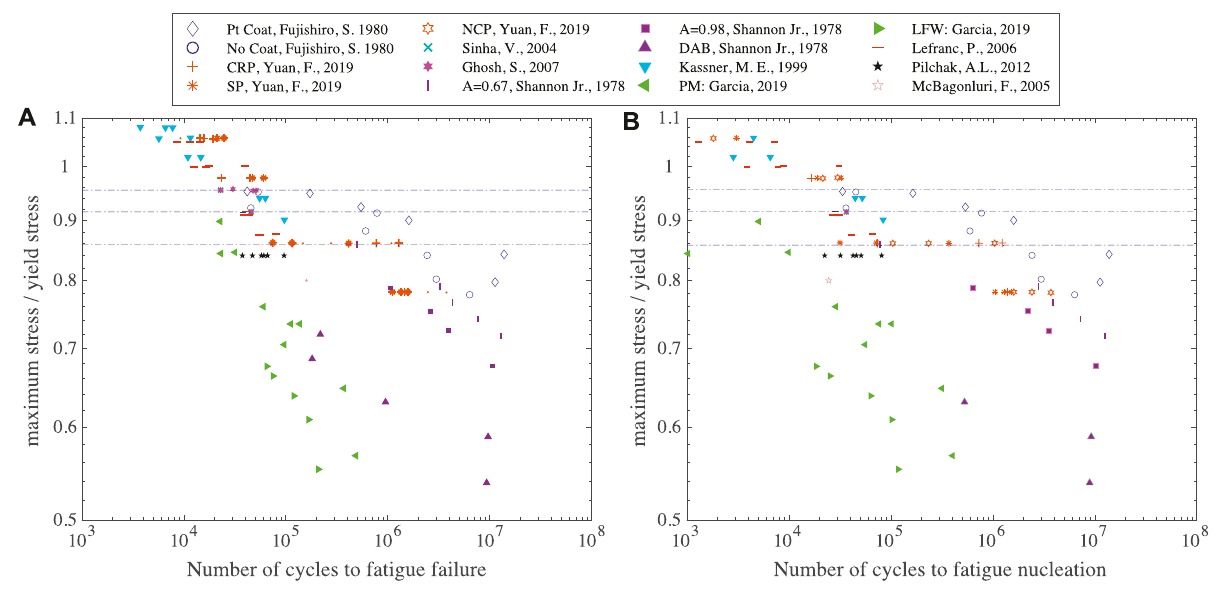
Several studies report experimentally measured number